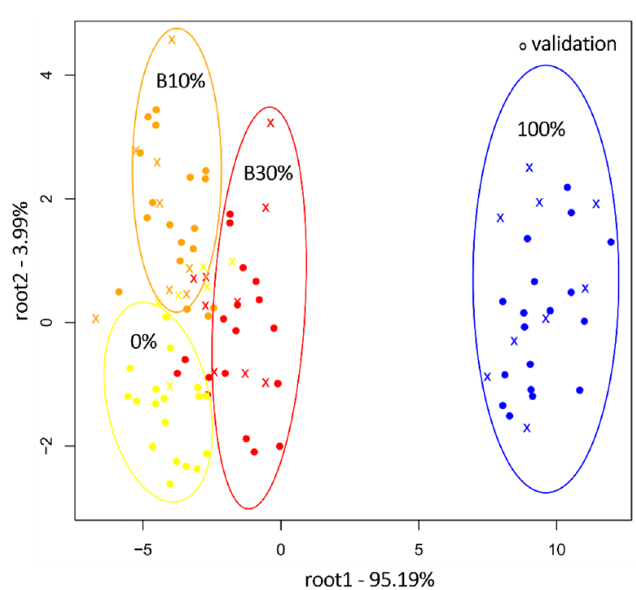
Figure 7. PCA-LDA classification of marketed blends B10% and B30%, pure Arabica (0%) and pure Robusta (100%) at the second overtone region (800–1100 nm), N = 108, NrPCs = 18.